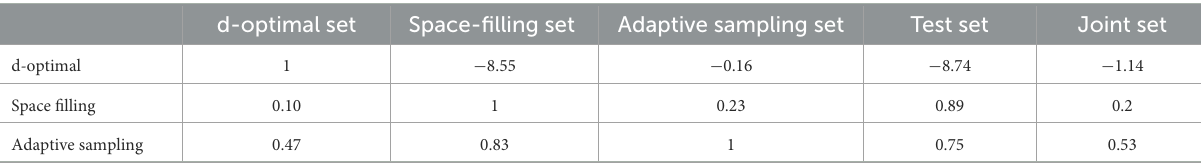
TABLE 5 HIC 36 R2 score of the trained models on the available datasets.